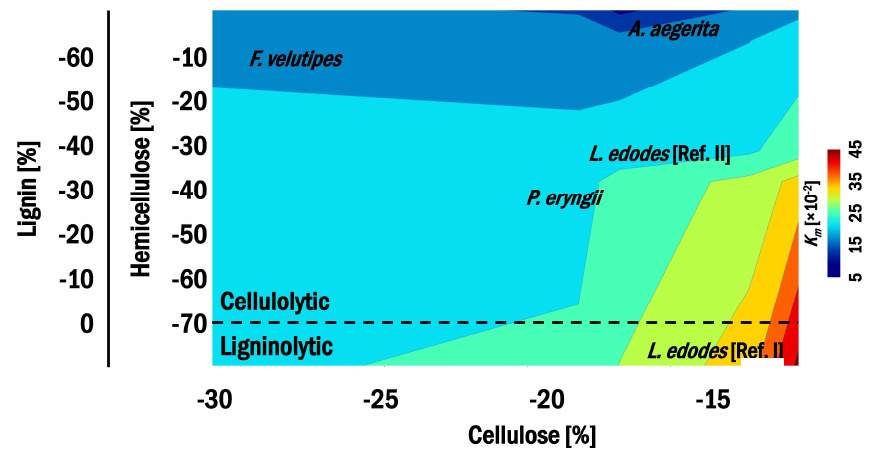
Figure 4. Mapping L. edodes and mushroom-producing exotic fungi by biodegradability (Km) on structural